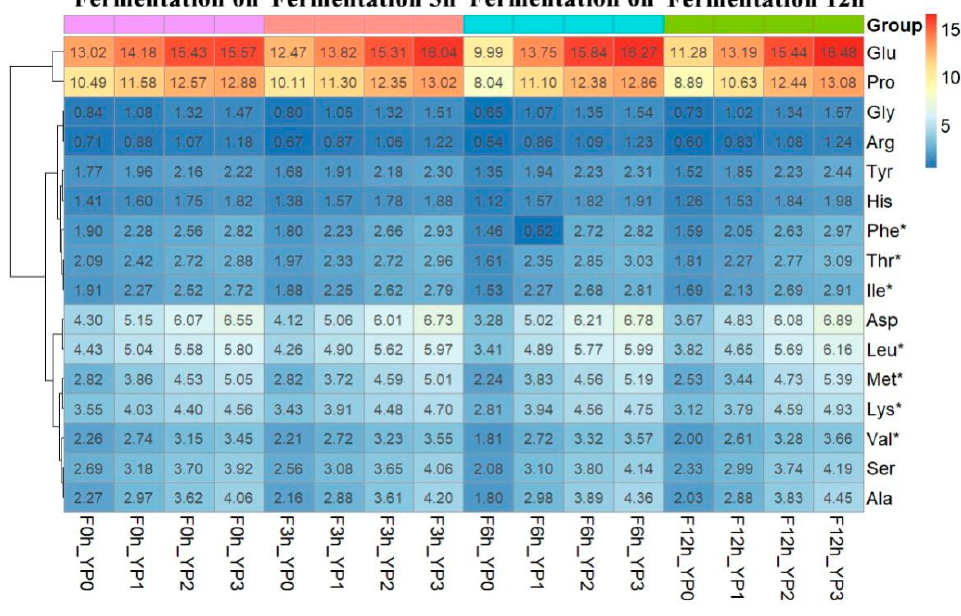
Figure 3. Heatmap of amino acid compositions and contents (%) during fermentation of yak milk yogurt.